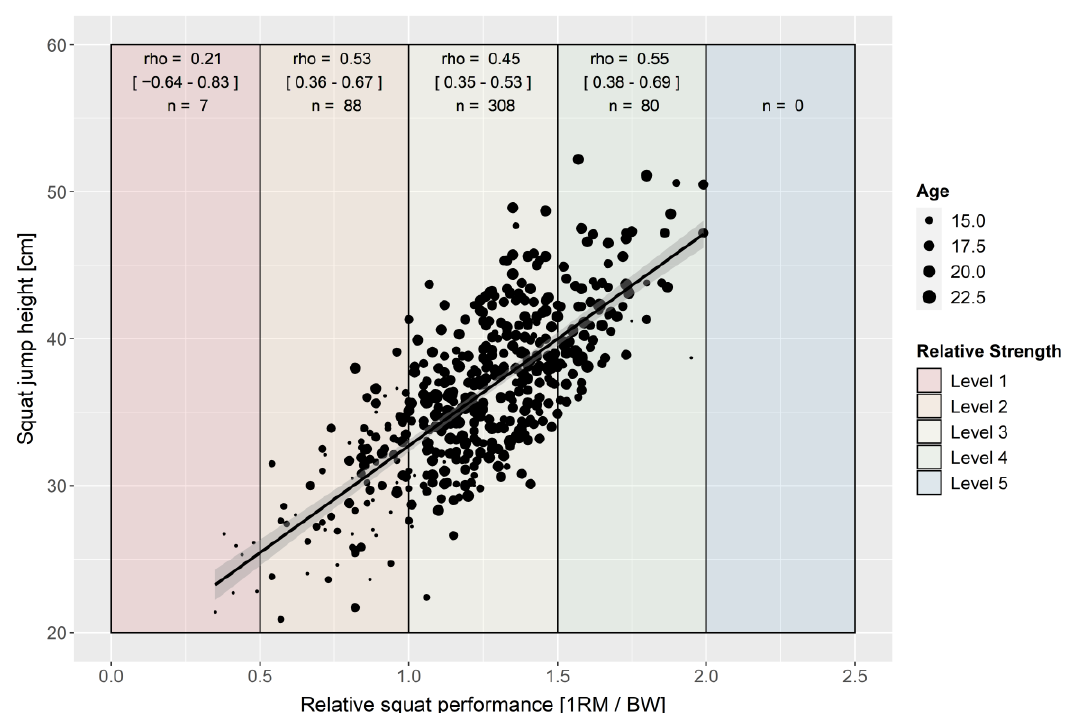
Figure 1. Scatterplot for relative squat and squat jump performance with trendline and 95% confi- dence interval (rho = 0.73 [ p < 0.001; 95% CI = 0.69 – 0.77]; r partial = 0.70 [ p < 0.001; CI95% = 0.66 – 0.75]; n = 483).